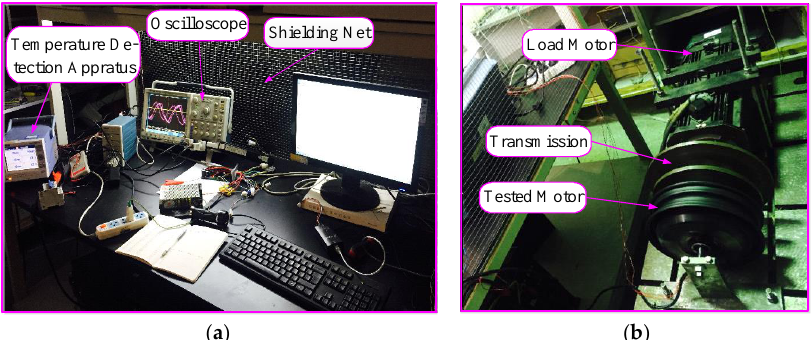
Figure 8. Experiment test bed of the outer-rotor motor: ( a ) control test bed on the left side of the shielding net; ( b ) physical test bed on the right side of the shield net.